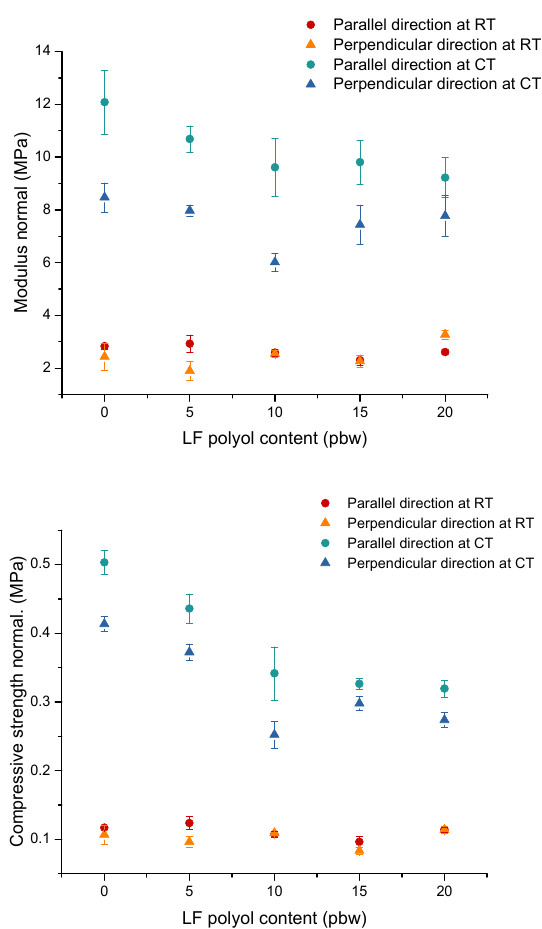
Figure 2. Compressive modulus and strength of foams at RT and CT. The mechanical strength of rigid PUR foams depends on many factors, including the type of raw materials used, the apparent density of the material, and its cellular structure, which is formed during the foaming process [42]. The results clearly indicate that the val- ues of compressive strength and compressive modulus for rigid PUR foams were lower at RT than CT. For CT temperatures, the compressive strength values ranged from 0.25 to 0.50 MPa, while for RT temperatures, the values were about 0.1 MPa. The higher values obtained for mechanical tests at cryogenic temperatures were due to the higher stiffness of rigid PUR foams at lower temperatures. Moreover, in both cases, it was observed that the values obtained for the tested systems in the direction parallel to the direction of foam growth were higher than in the perpendicular direction. The differences in the values in different directions were due to the anisotropic structure of the foams, which were con- firmed by the anisotropy coefficient (Table 4). It is worth noting that the parameter tested under different temperature conditions indicates that these materials have a good com- pressive strength of over 0.1 MPa. In the case of the rigid PUR foams with the highest content of LF polyol, the highest difference in compressive strength and modulus were noticed when comparing the results in parallel and perpendicular directions to the foam growth direction. This foam also had the highest anisotropy coefficient and average cell area in both foam cross-sections. Increasing the LF polyol content in the PUR system